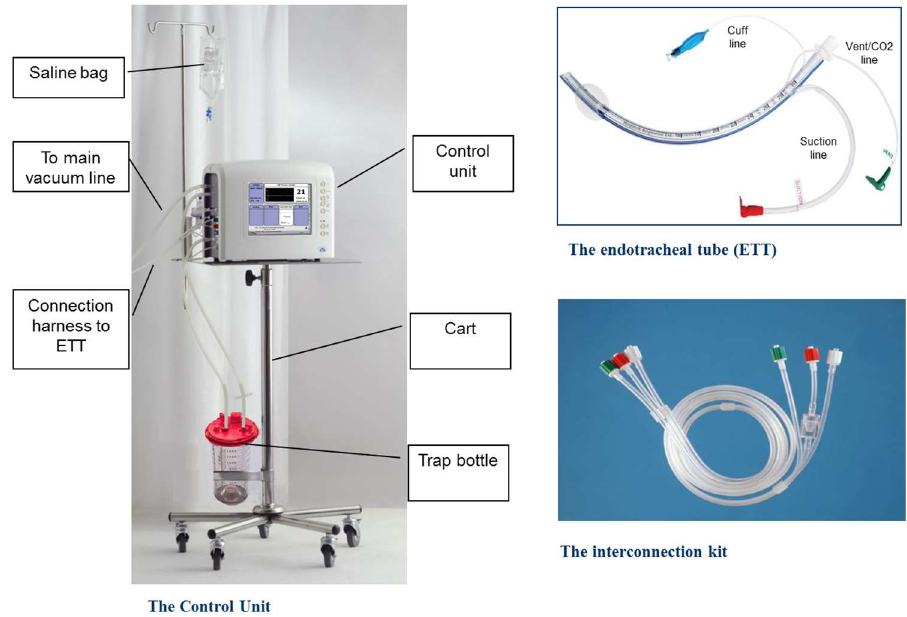
Fig 5. AnapnoGuard 100 systemoverview.